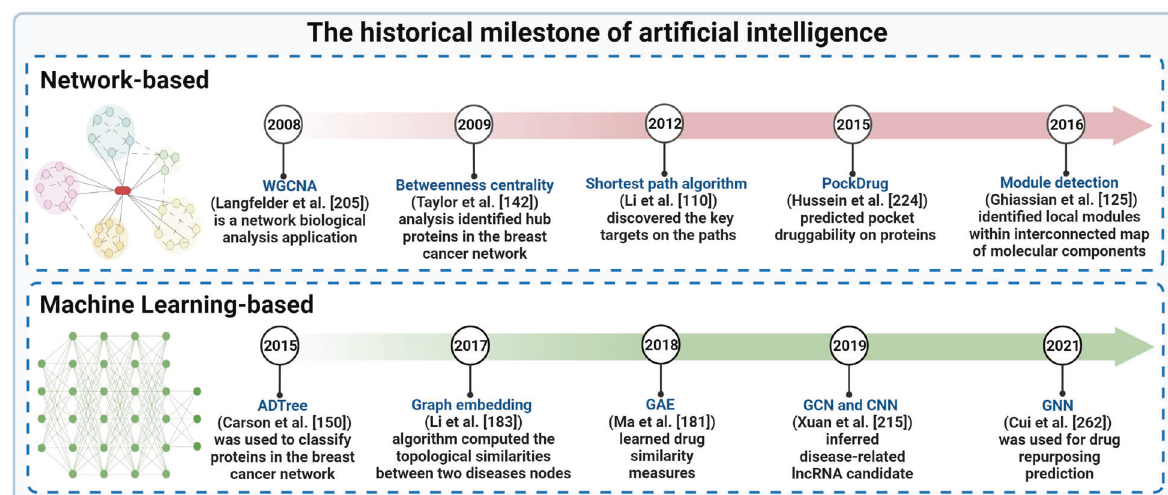
Fig. 1 The historical milestones of network-based and ML-based biology analysis. (Created with